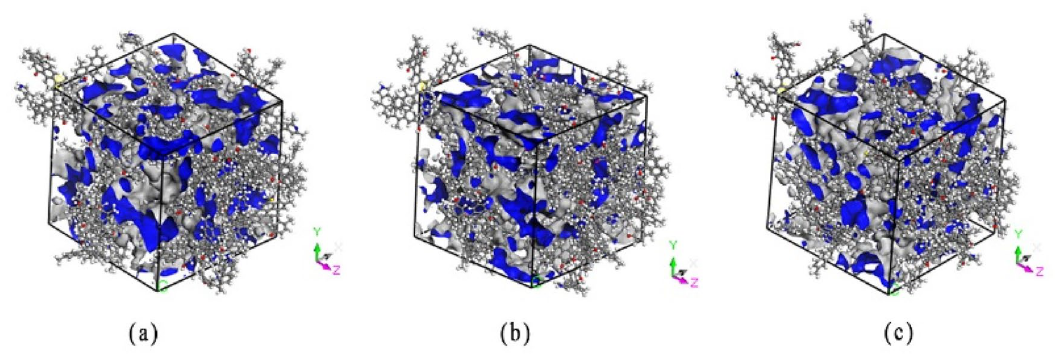
Figure 3. Supercell structures of coal at different temperatures: ( a ) 308.15 K; ( b ) 318.15 K; ( c ) 328.15 K.